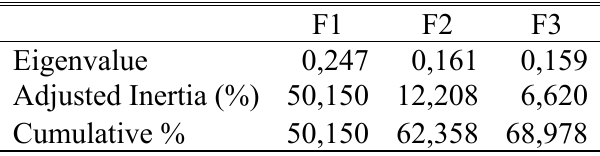
Table A.10.1. Eigenvalues and percentages of inertia absorbed by the first three axes (F1, F2 and F3) of the Multiple Correspondence Analysis (MCA).